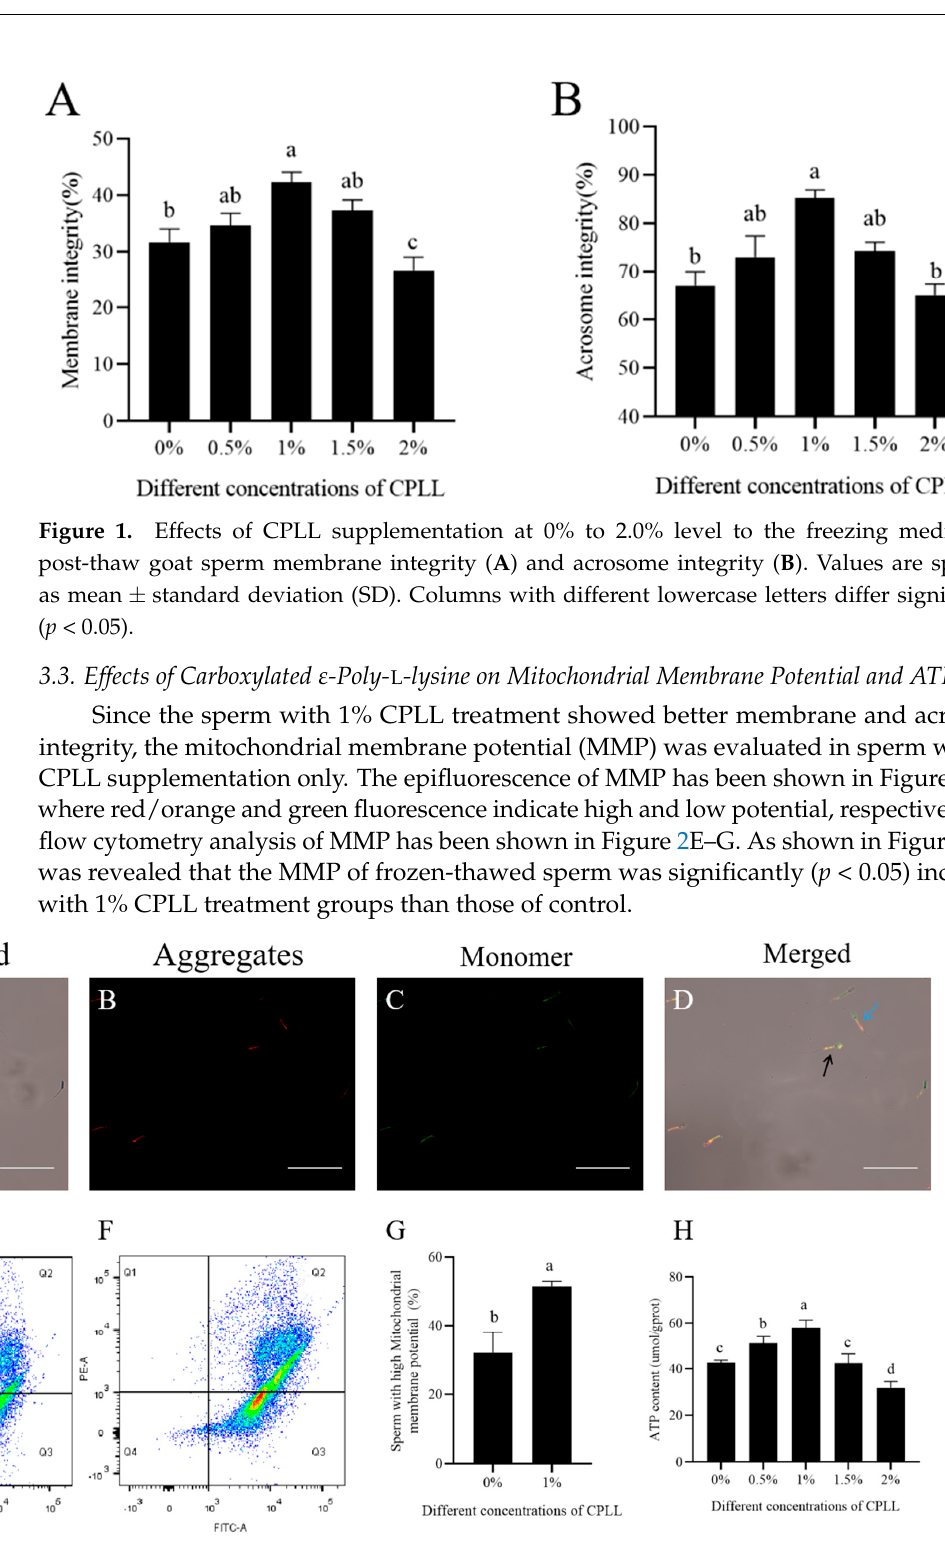
Figure 2. ( A – D ) Fluorescence microscopic observation of the mitochondrial membrane potential (MMP) of post-thaw goat sperm cryopreserved with or without CPLL, where the blue arrows indicate high MMP and the black arrows indicate low MMP. ( E , F ) MMP fluorescence emission in flow cytometry and ( G ) the comparison of MMP at 1% CPLL supplementation to the control. ( H ) Effects of CPLL supplementation at 0% to 2.0% level to the freezing medium on post-thaw goat sperm ATP content. Values are specified as mean ± standard deviation (SD). Columns with different lowercase letters differ significantly ( p < 0.05). Scar bar = 30 μ m.